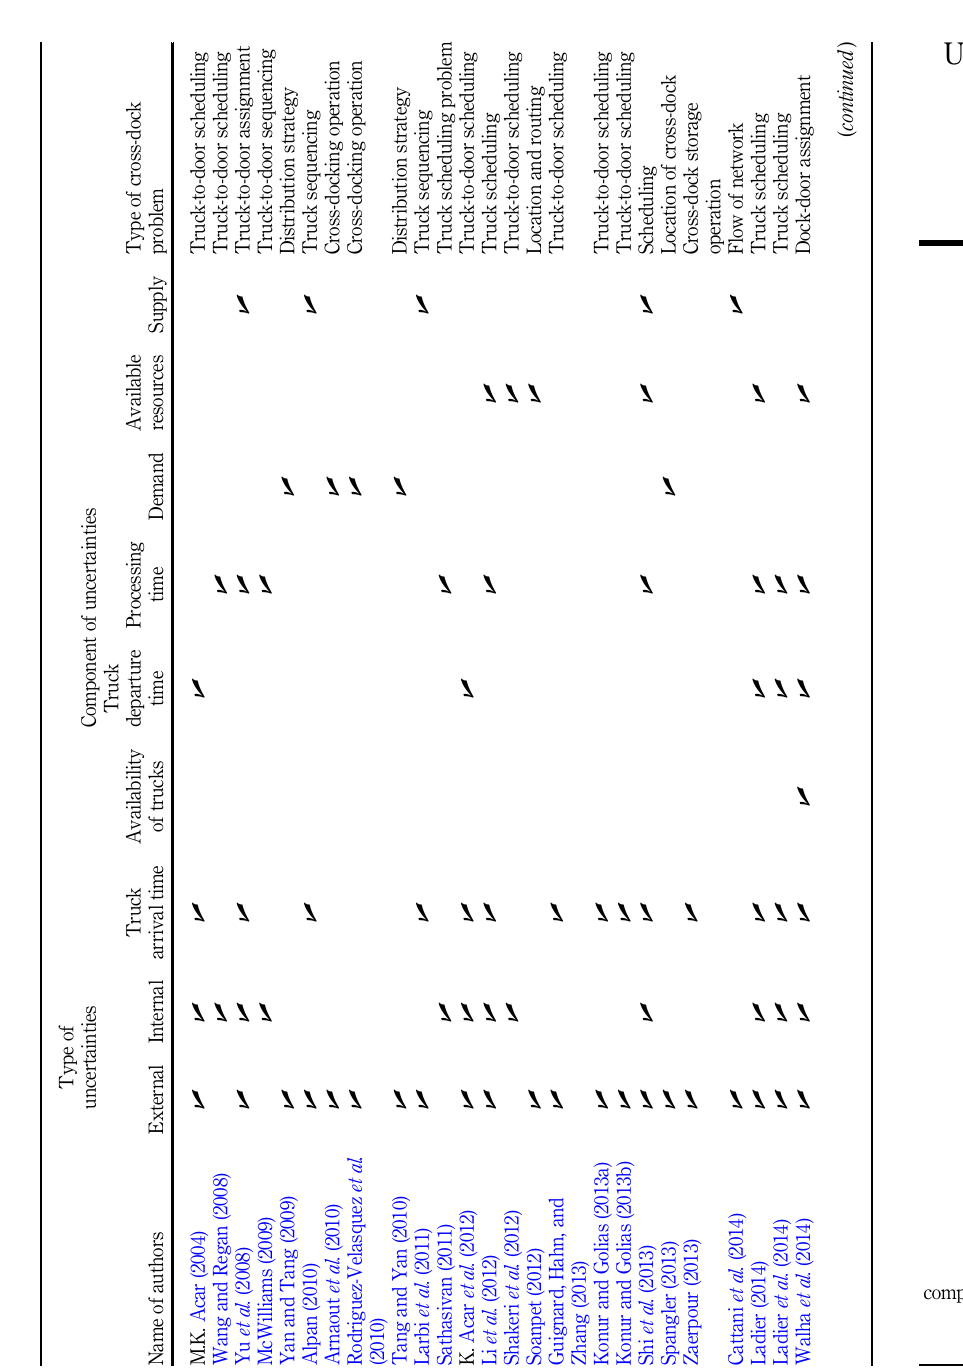
components and types of